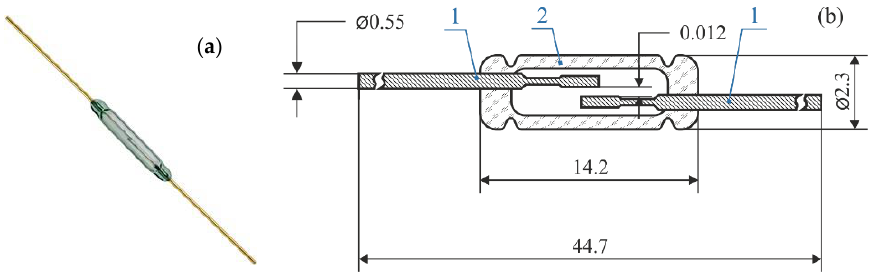
Figure 2. General view ( a ) and design of reed switch MKA-14 ( b ): (1) permalloy contact blades, (2) glass envelope. The dimensions are shown in mm.